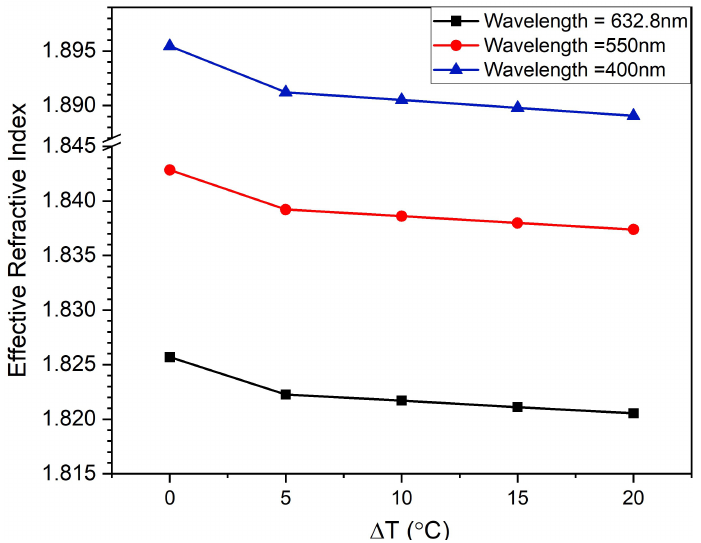
Figure 3. Effect of thermal variation on effective refractive index of the proposed structure. Table 1. Effect of increasing temperature on excitation angle and sensitivity at different incident wavelengths of 400 nm, 550 nm and 632.8